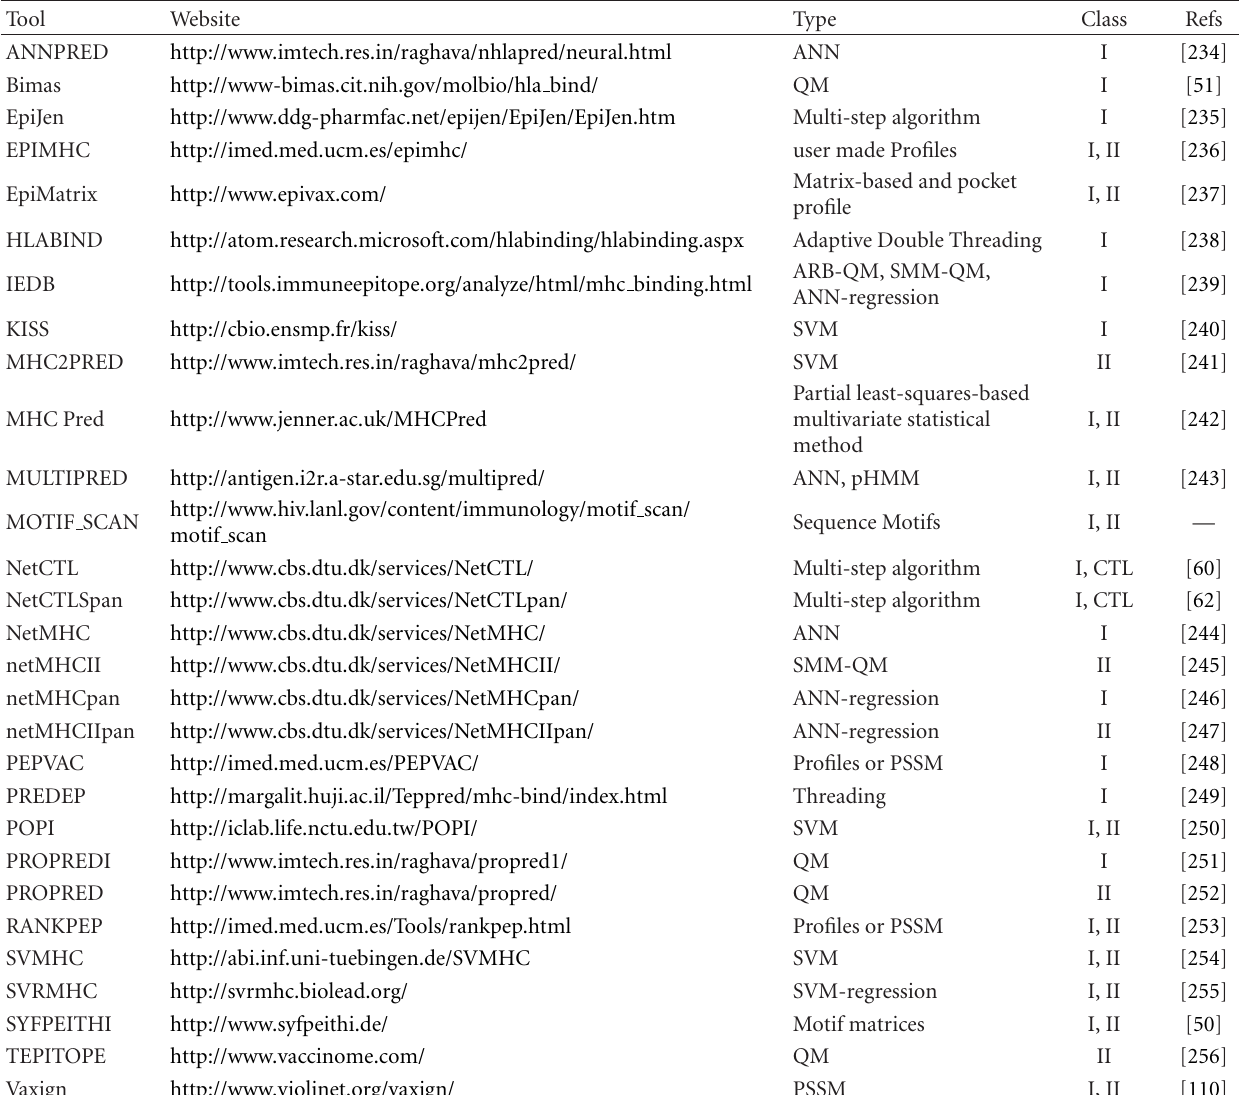
Table 1: List of online tools for T-cell epitope